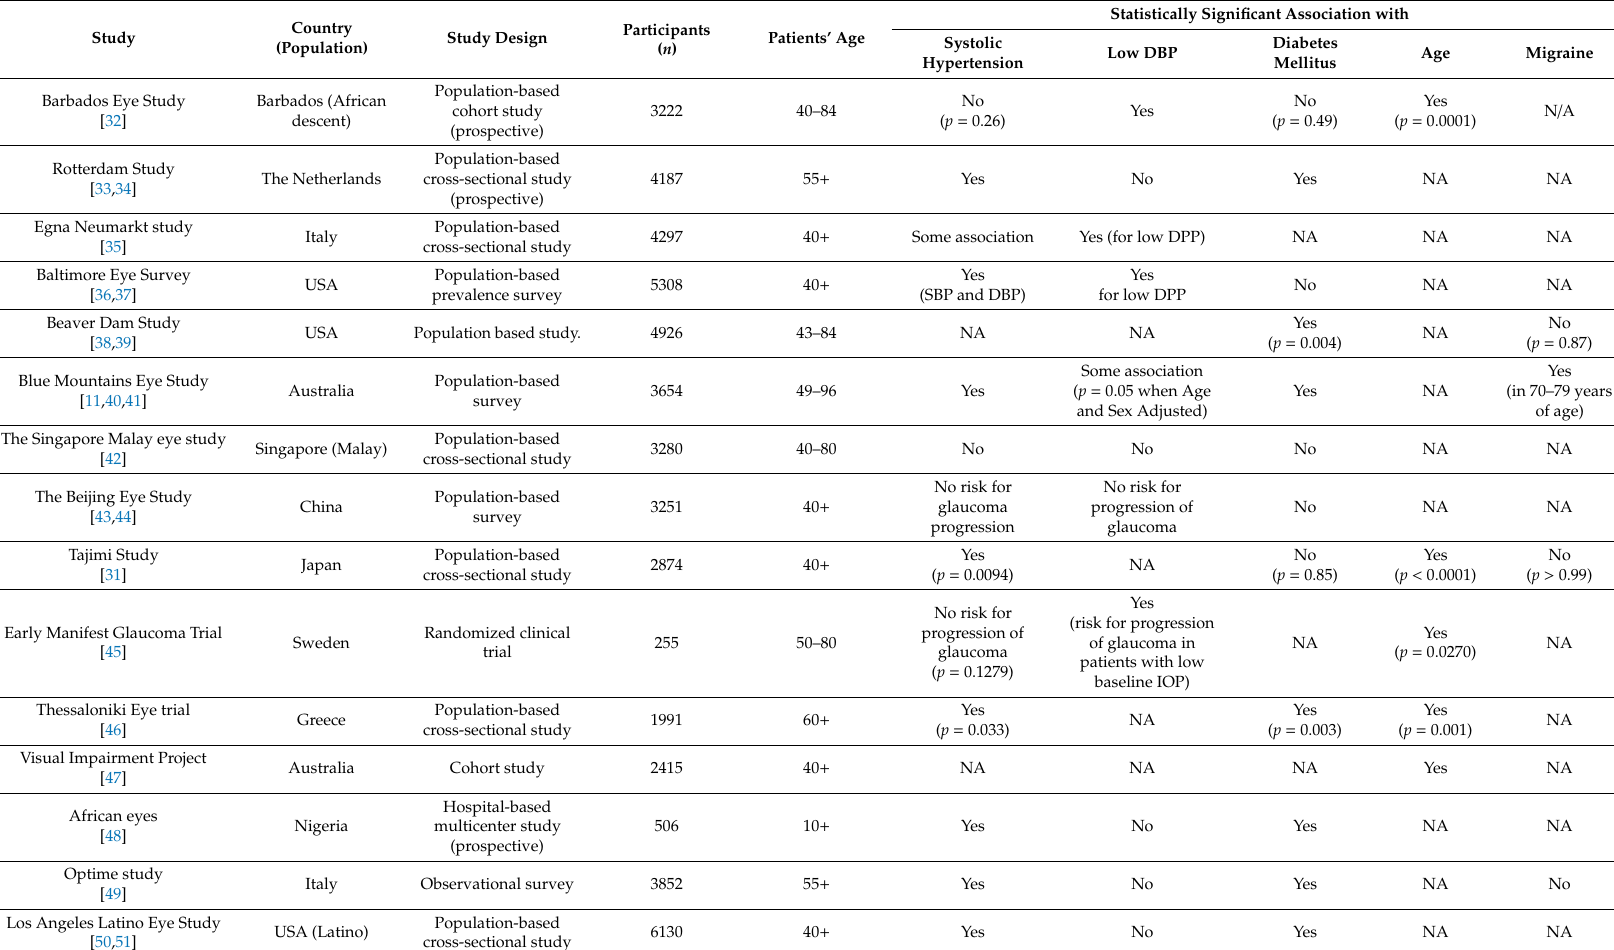
Table 1. Studies investigating systemic vascular risk factors in primary open angle